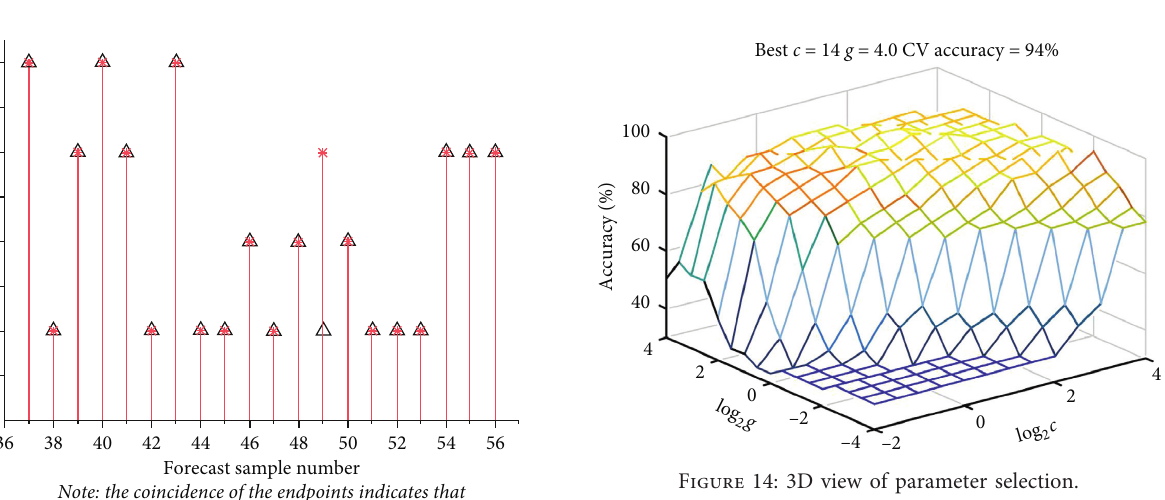
Figure 12: The effect and error of training data network classification. (a) The effect PNN network training and (b) The error map PNN network training.